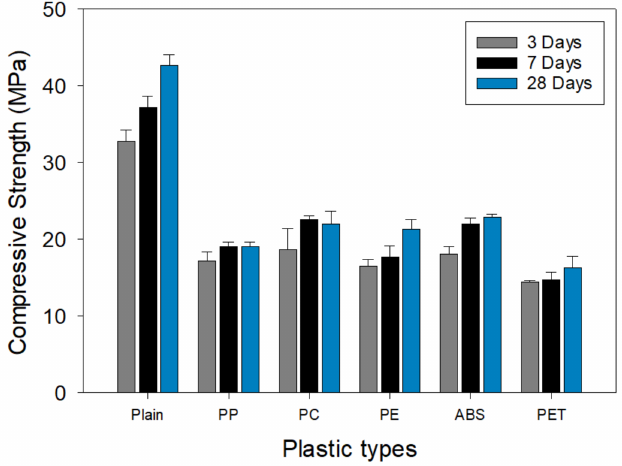
Figure 20. Compressive strength of cementitious composites according to plastic